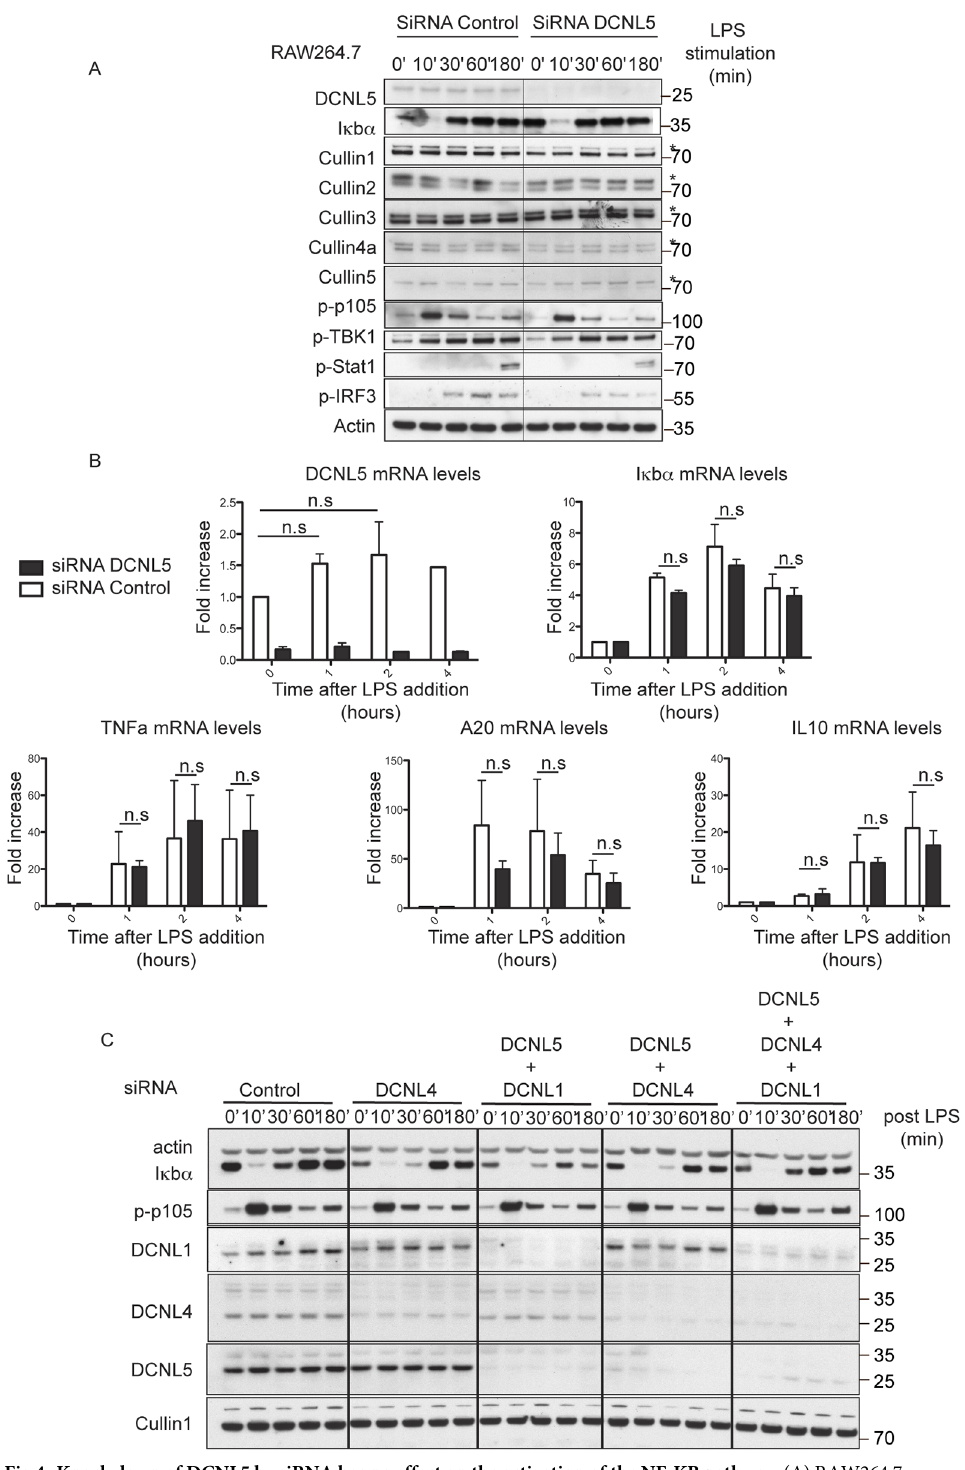
Fig 4. Knock down of DCNL5 by siRNA has no effect on the activation of the NF-KB pathway. (A) RAW264.7 were electroporated with siRNA and stimulated with LPS 24 hours later. Knockdown efficiency was measured by immunoblot. (B) As in (A) RAW264.7 were electroporated with siRNA and stimulated with Poly (I:C) 24 hours later for the indicated times. Total RNA was extracted and the mRNA encoding DCNL5, IFN β , CXCL10, ISG15 and MX1 were measured by qRT-PCR as described under the “Experimental Procedures.” The results show relative mRNA levels compared with